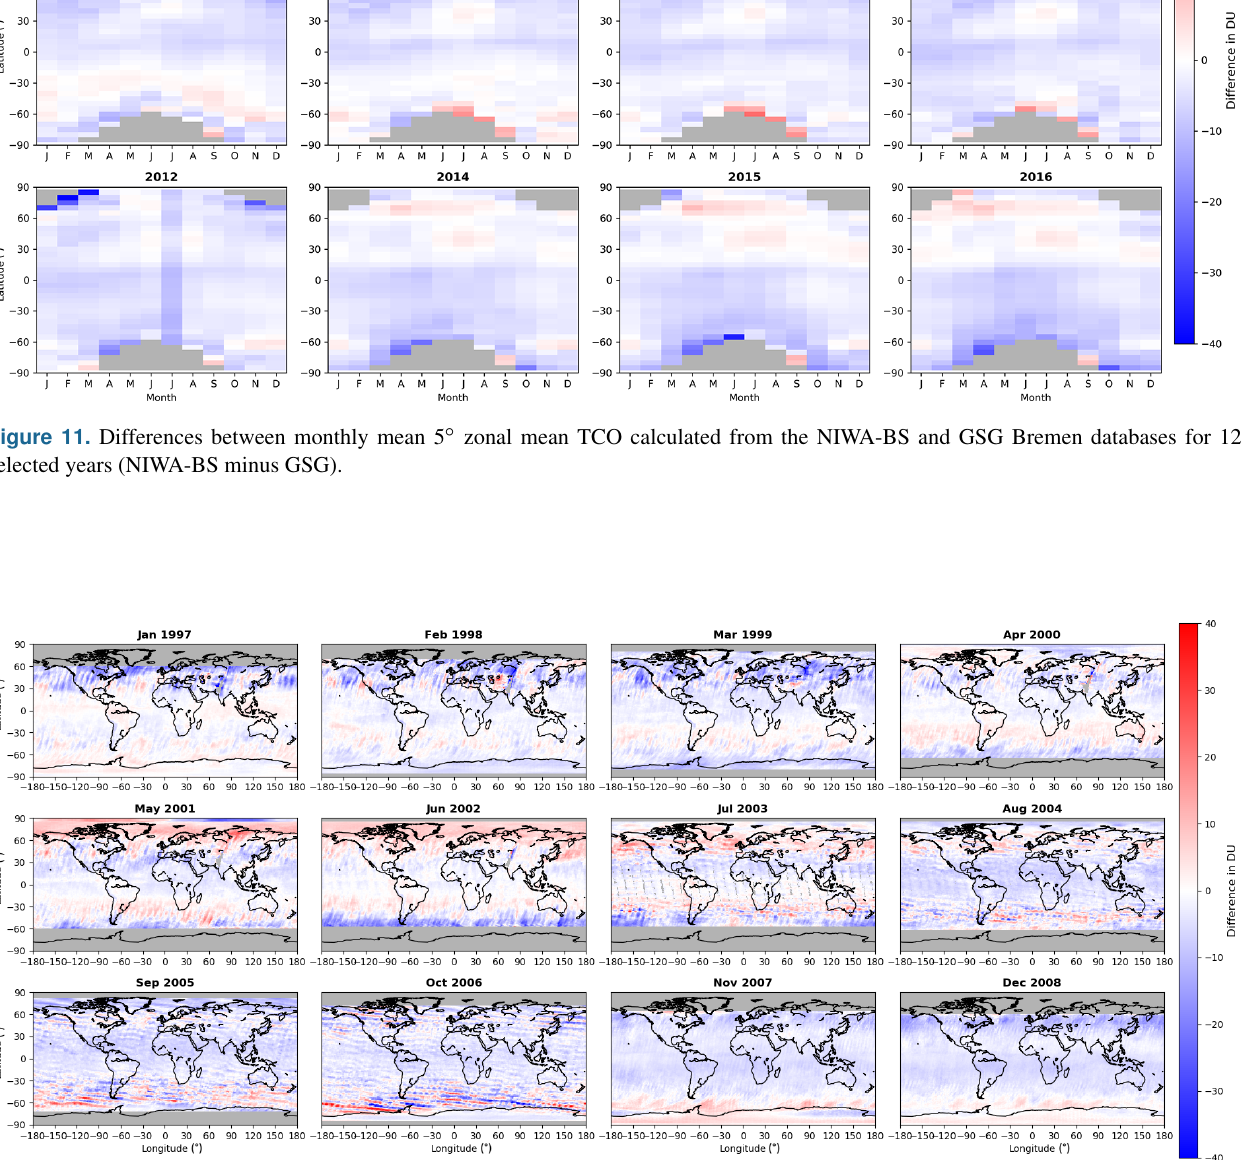
Figure 12. Differences between monthly mean TCO fields calculated from the NIWA-BS database and those available from the ESA CCI database for 12 selected